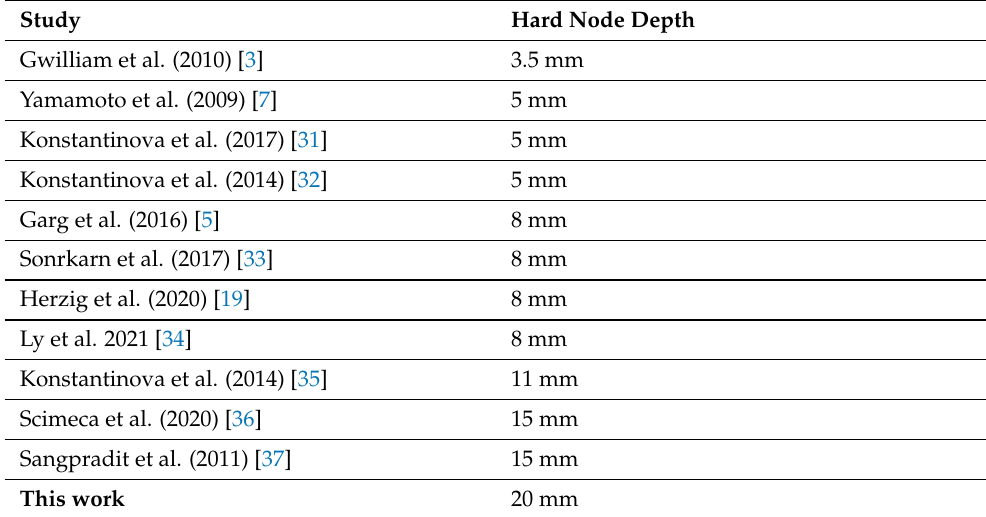
Table 2. This work represents the deepest hard node inclusion to be palpated in the reviewed literature.